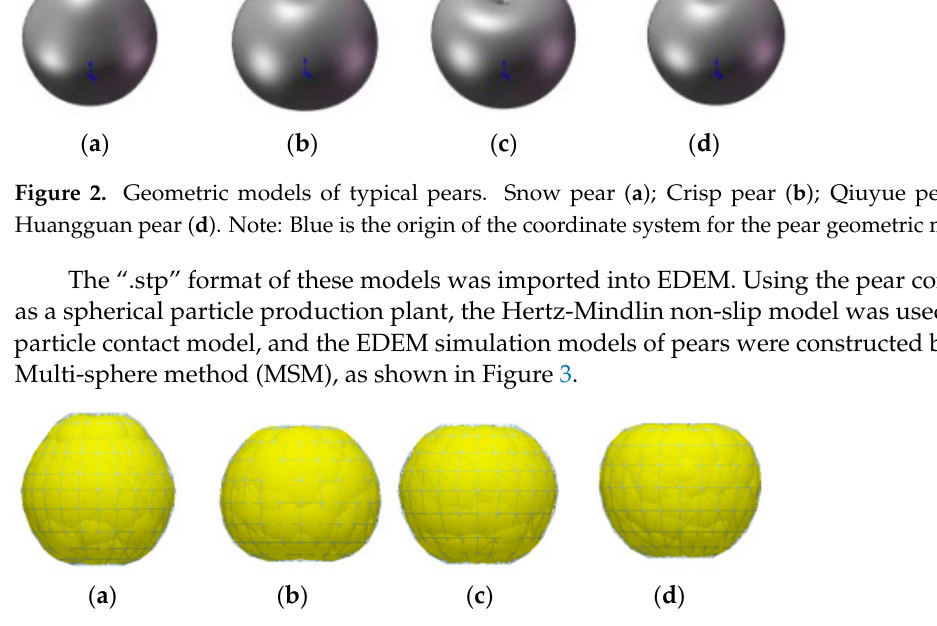
Figure 1. Outer contour curve of Snow pear.